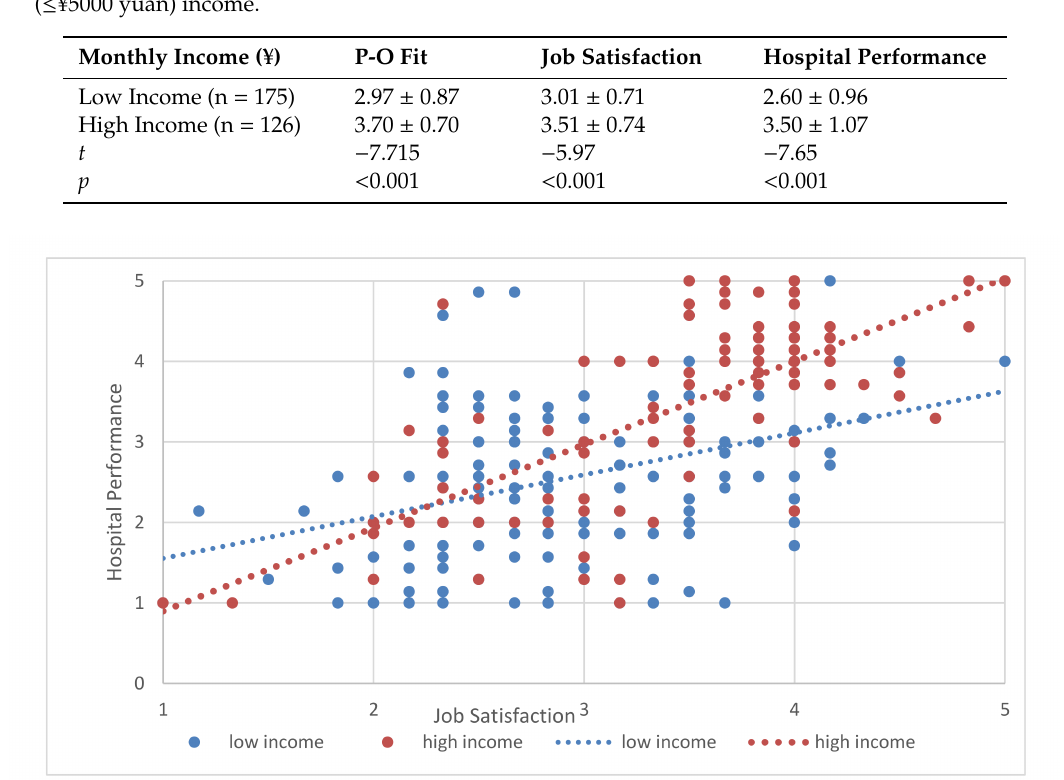
Figure A1. Correlation between job satisfaction and hospital performance categorized by